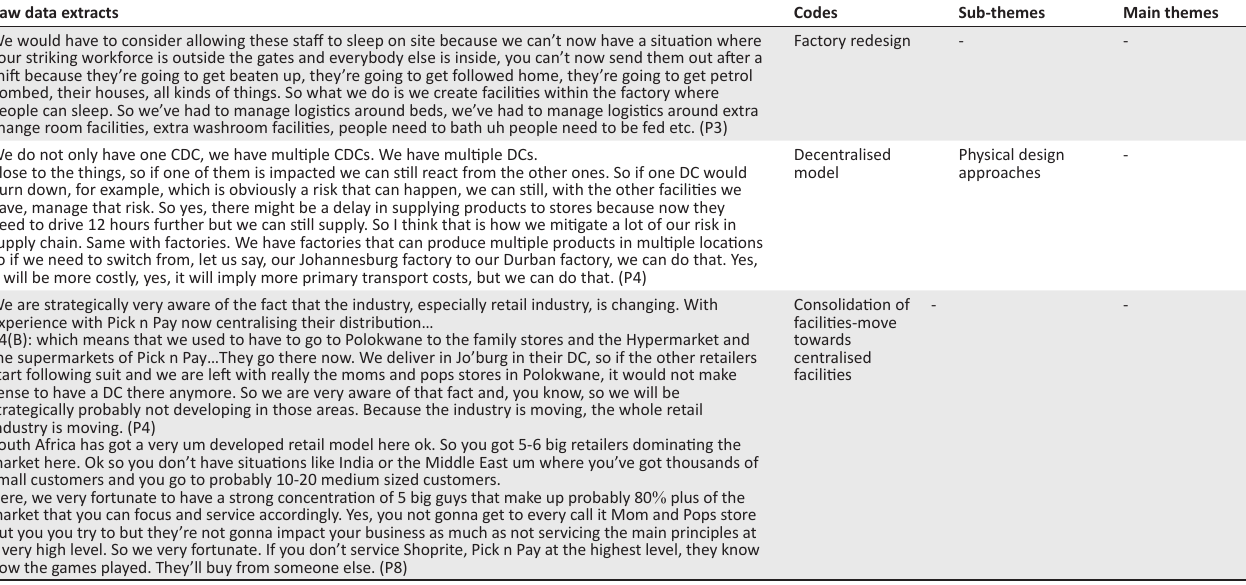
TABLE 1-A1 (Continues...): The link between the codes, sub-themes and main themes identified in this